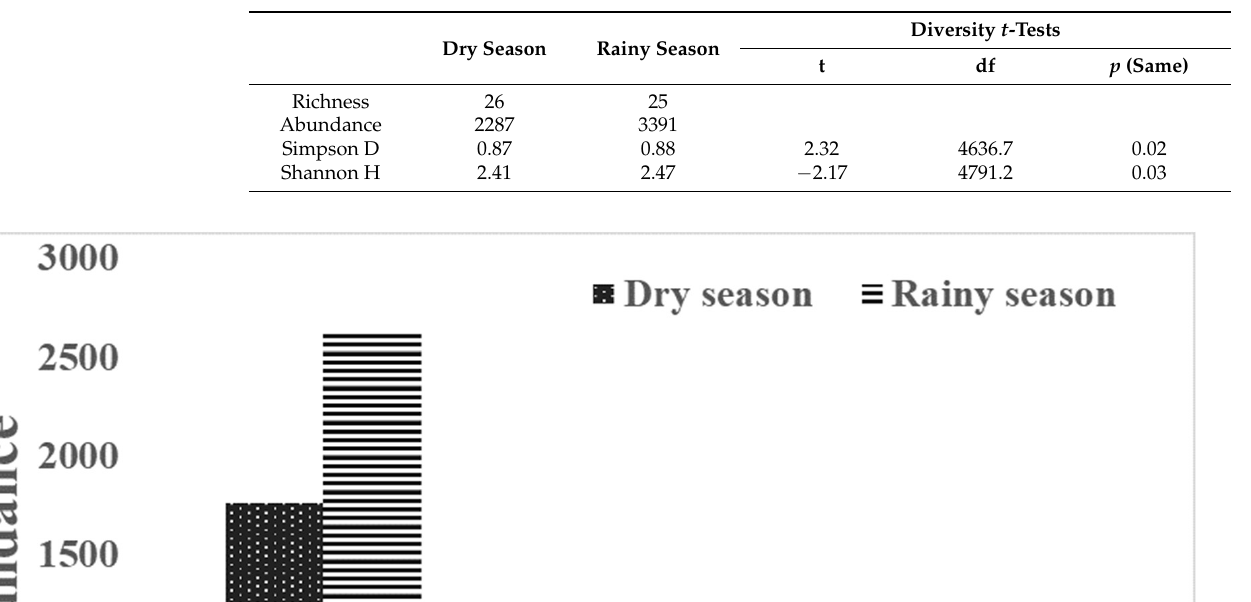
Table 5. Diversity variation of frog species between rainy and dry seasons.